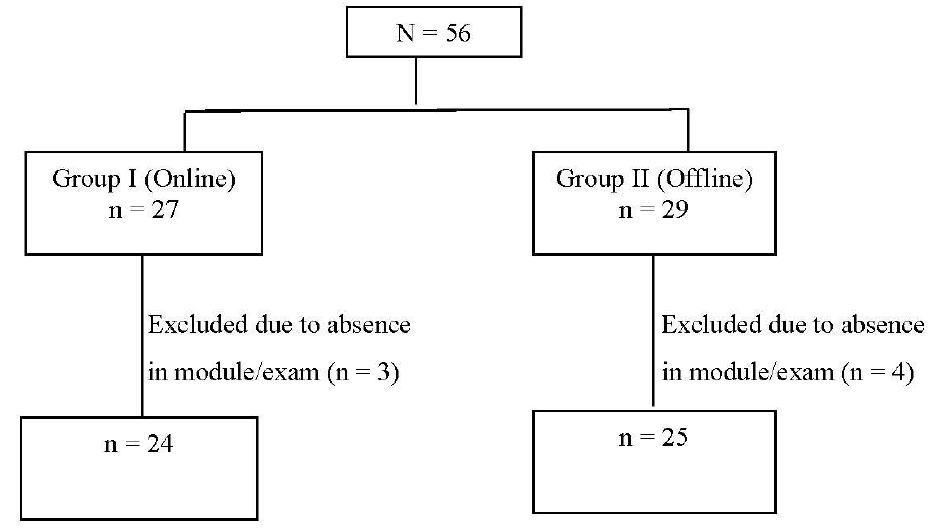
Figure 2. Study flow chart.